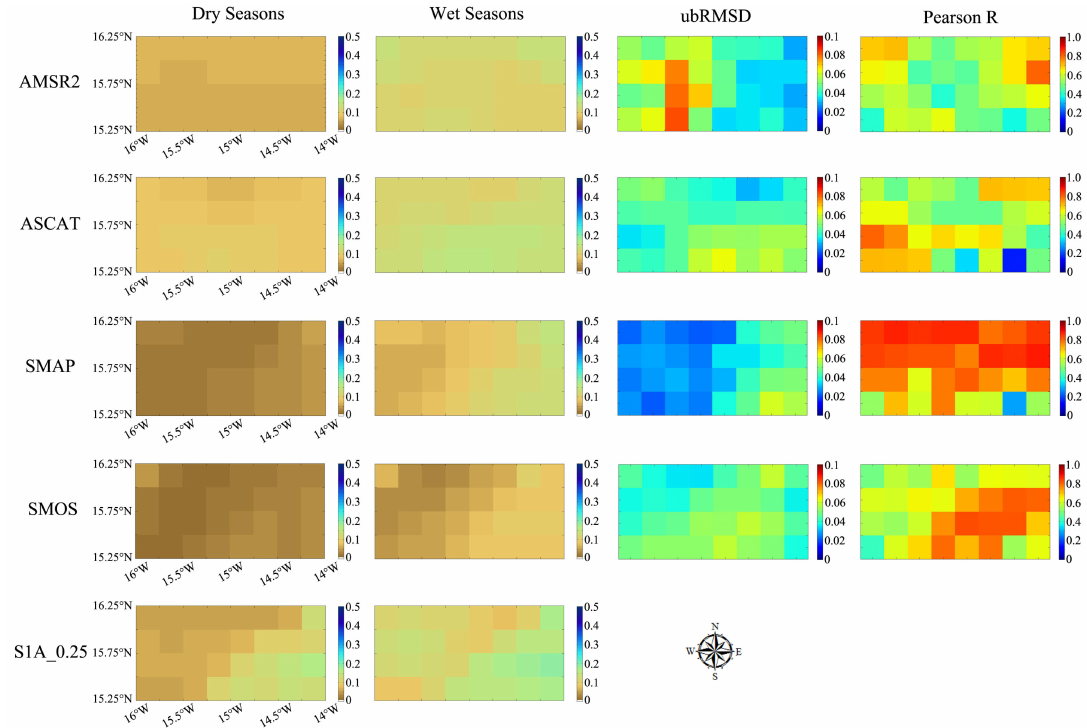
Figure 4. Comparison between S1A_0.25 and the microwave soil moisture. Column 1: the averaged soil moisture in the wet seasons; Column 2: the averaged soil moisture in the dry seasons; Column 3: the ubRMSD of the microwave products calculated with S1A_0.25 pointwise; Column 4: Pearson’s correlation coefficient ( R ) of the microwave products calculated with S1A_0.25